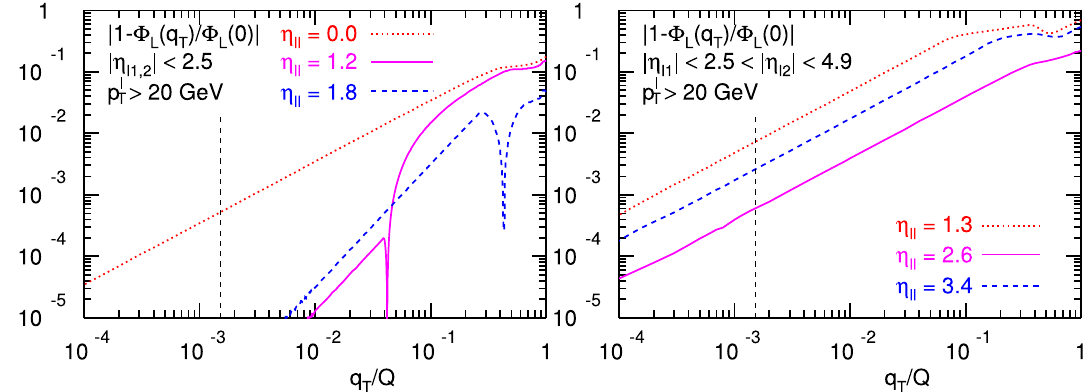
| ≤ 2 . 5 for i = 1 , 2. Right: Cuts selecting central pseudo-rapidities | η l i | ≤ 2 . 5andtheotheratforward oneleptonatcentralpseudo-rapidity | η l 1 | ≤ 4 . 9. The vertical dashed line indicates pseudo-rapidity, 2 . 5 ≤ | η l 2 the minimum value r min cut = 0 . 15% used in MATRIX as a slicing cut